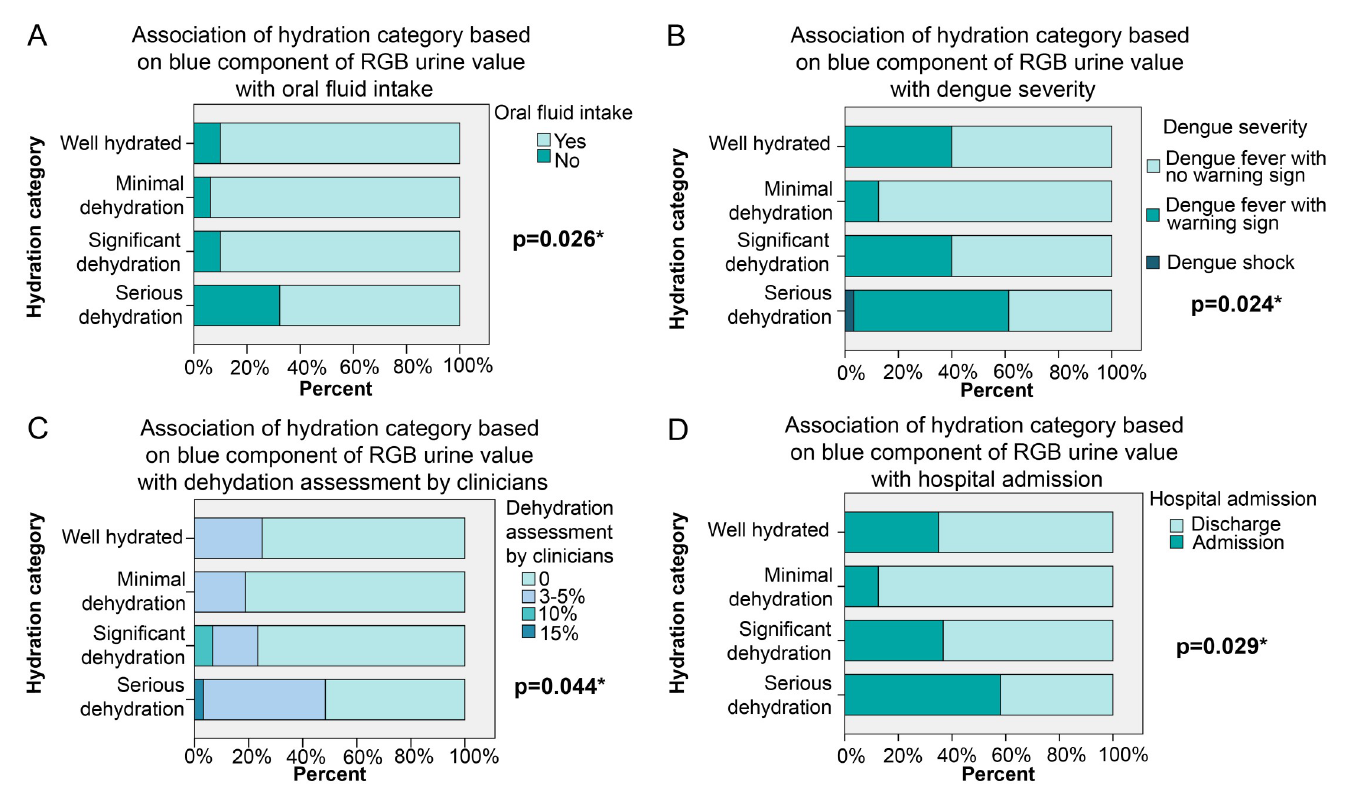
Fig 2. Association of the blue component of RGB urine colour value with dehydration assessment by clinician, dengue severity, oral fluid intake and hospital admission. Hydration category was based on the blue component of RGB urine value according to the Body Hydration Tracker system proposed by Jeanette et al. (2015); a value < 40 indicates serious dehydration, 40 to 100 indicates significant dehydration, 100 to 170 indicates minimal dehydration and > 170 indicates well hydration [18]. � denotes significant p-value calculated using Mantel-Haenszel statistics.